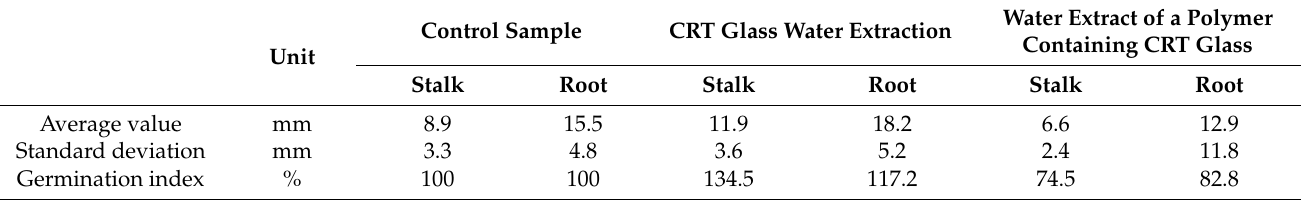
Table 7. Results of phytotoxicity determinations: mean values and standard deviations of the root and stem increment of cress (mm) and the value of the germination